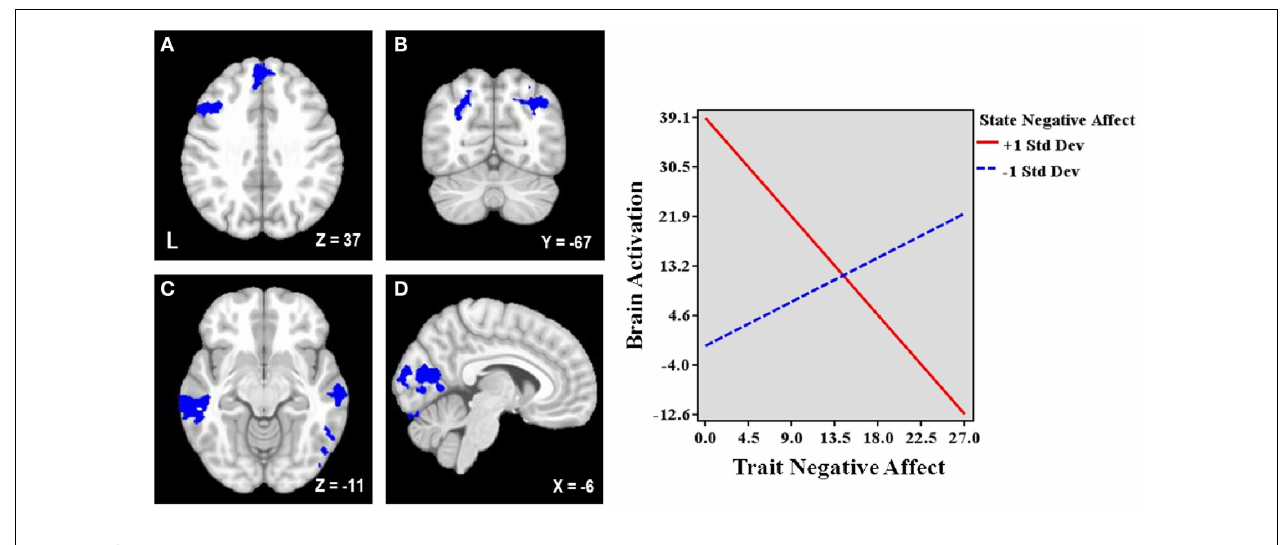
two-way interaction for each region shows that trait NA’s relationship with these brain areas depends on the level of co-occurring state NA, such that increased trait NA is associated with decreased activation in all of these areas at high levels of state NA but with increased activation at low levels of state NA. Depicted is a representative graph from left MFG.